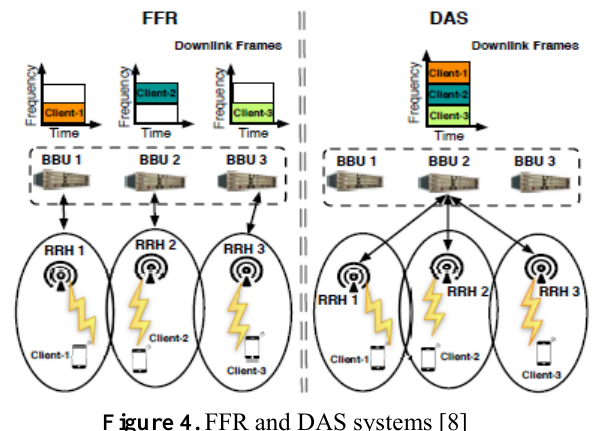
Figure 4. FFR and DAS systems [8]